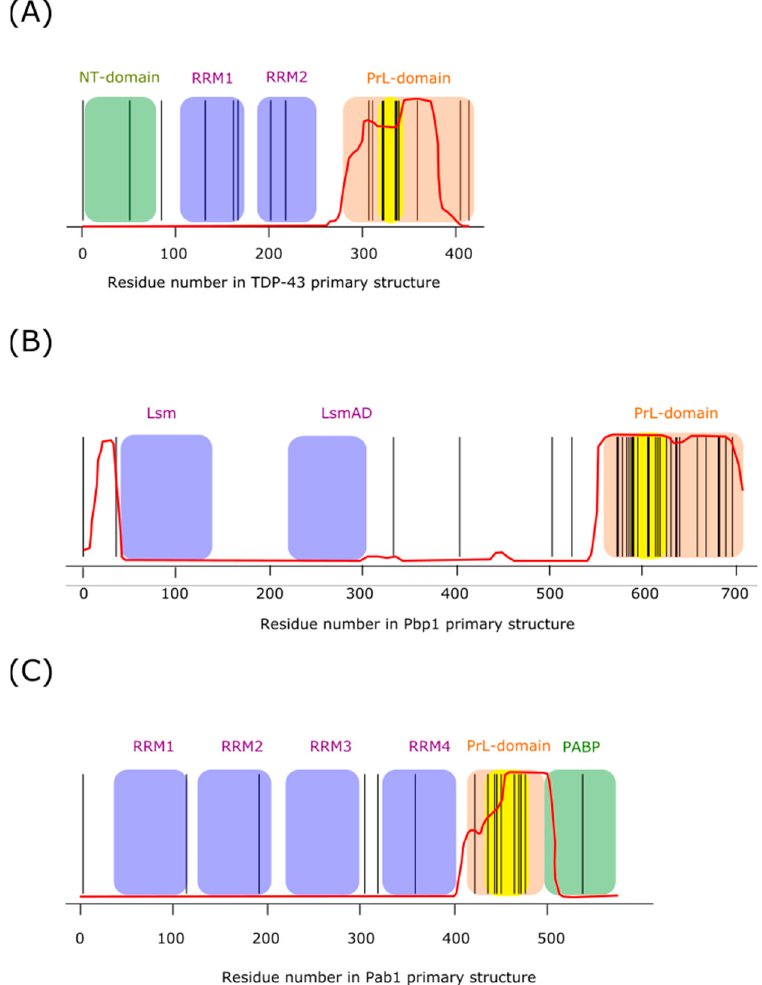
Figure 3. Modular architecture of three scaffold proteins containing methionine-rich LC domains. Methionine positions in the primary structure are indicated by vertical black lines. ( A ) TDP-43 presents a folded N-terminal domain (green box) with six β -strands [151], which has been shown to play an important role in the aggregation of TDP-43 monomer. This protein also has two RRMs (blue boxes) and a PrL domain (salmon box) that host a redox sensor formed by methionine residues (yellow box). ( B ) Pbp1, the yeast ataxin-2 orthologous, exhibits two RNA binding domain, Lsm and LsmAD, (blue boxes) and one methionine-rich LC regions (salmon box) containing a redox sensor (yellow box) that controls the aggregation ability of the protein. ( C ) Pab1 has 4 RRMs (blue boxes) one PrL domain (salmon box) enriched in methionine residues (yellow box) and a poly(A)-binding protein (PABP) domain towards the C-terminal of the polypeptide chain (green box). The red curves represent the score provided by the software PLAAC for each protein sequence. PLAAC uses Hidden Markov Models to compute the probability of a region from the analyzed protein being an LC region belonging to the PrLD category [156].